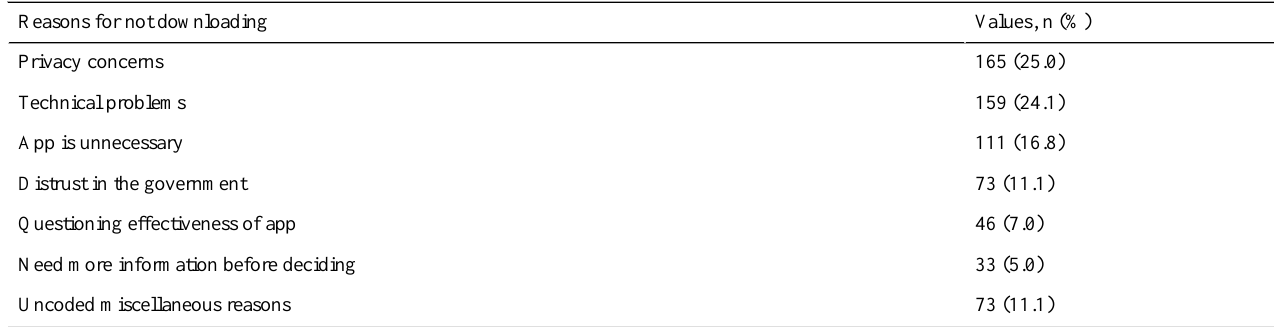
Table 2. Reasons for not downloading the COVIDSafe app